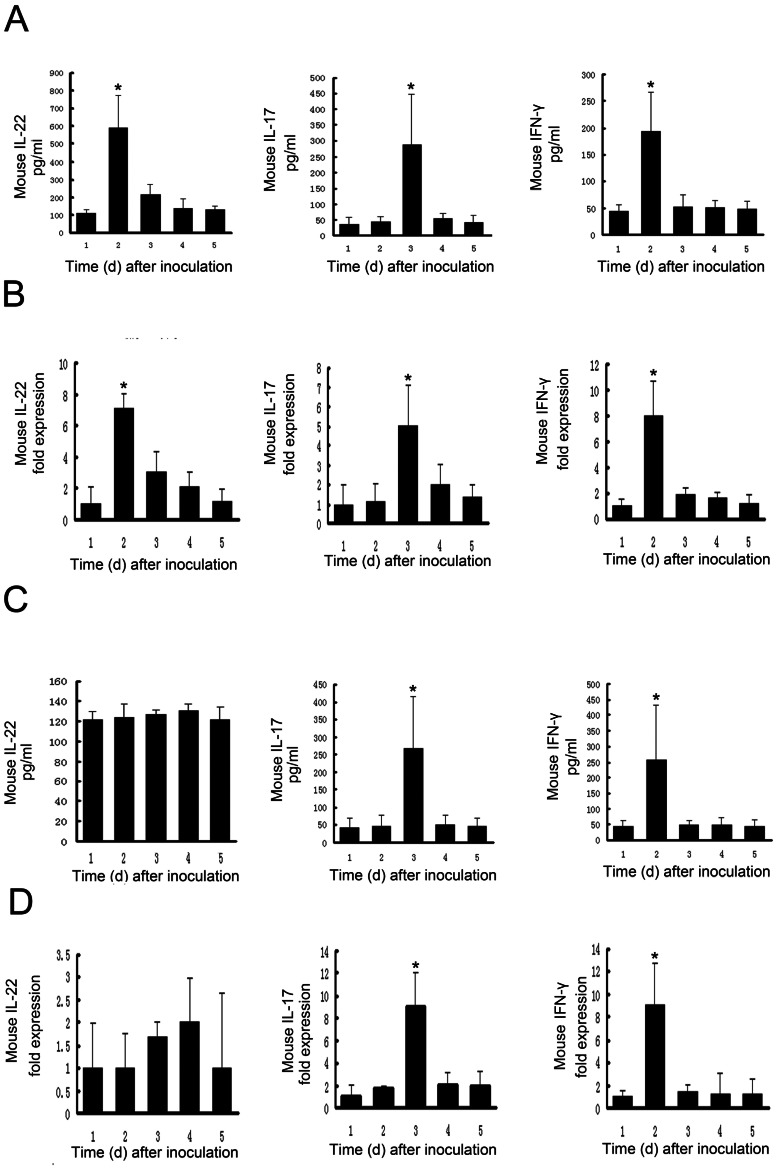
Differential cytokine profiles induced by R. pusillus and R. variabilis infections.(A) Detection of IL-22, IL-17, and IFN-γ production of protein from skin biopsies of R. pusillus lesions by ELISA, *P<0.05. (B) mRNAs of IL-22, IL-17, and IFN-γ from skin biopsies of R. pusillus lesions were detected by qRT-PCR. qRT-PCR data are presented as averaged(n = 5/per group),GAPDH-normalized fold-change versus the PBS-injected sample with the greatest ΔCt, *P<0.05. (C) Detection of IL-22, IL-17, and IFN-γ production of protein from skin biopsies of R. variabilis lesions by ELISA, *P<0.05. (D) mRNAs of IL-22, IL-17, and IFN-γ from skin biopsies of R. variabilis lesions were detected by qRT-PCR and R. variabilis lesions. qRT-PCR data are presented as averaged(n = 5/per group), GAPDH-normalized fold-change versus the PBS-injected sample with the greatest ΔCt, *P<0.05.